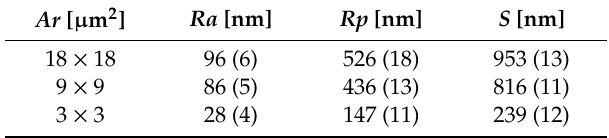
Table 1. Mean (SD) roughness parameters of healthy human surfaces (N = 357).